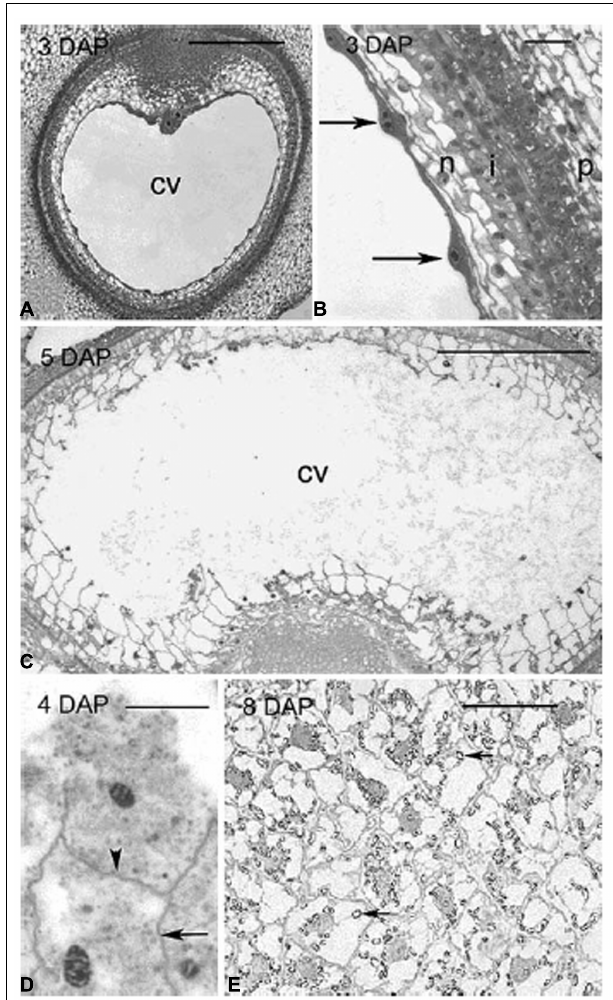
FIGURE 3 | Different stages of endosperm development in barley. Light micrographs of sections through barley grains showing stages of endosperm development from 3 to 8 DAP. (A) 3 DAP: a thin layer of syncytial cytoplasm surrounds a large central vacuole. (B) Details of the syncytium in (A) . Arrows indicate the position of nuclei along the perimeter of the central cell, all enclosed within discrete layers of maternal tissue. (C) 5 DAP: cellularization occurs centripetally with repeated cycles of anticlinal wall formation, mitosis and periclinal wall formation. (D) 4 DAP: shows the wavy appearance of anticlinal walls (arrow) and a periclinal wall (arrowhead) separating two recently divided daughter nuclei. (E) 8 DAP: the endosperm was fully cellularized and starch granules (arrows) had accumulated within each cell. cv, central vacuole; i, integuments; n, nucellus; p, pericarp. Scale bars = 300 μ m (A,C) , 50 μ m (B,E) , 20 μ m (D) . Reproduced with permission fromWilson etal.